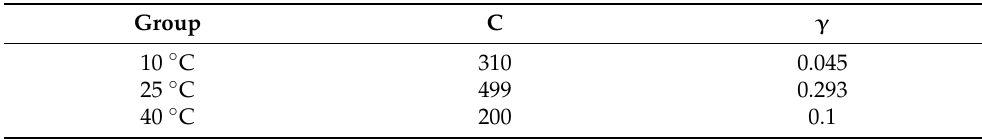
Table 4. The optimum parameter of the SVR model.